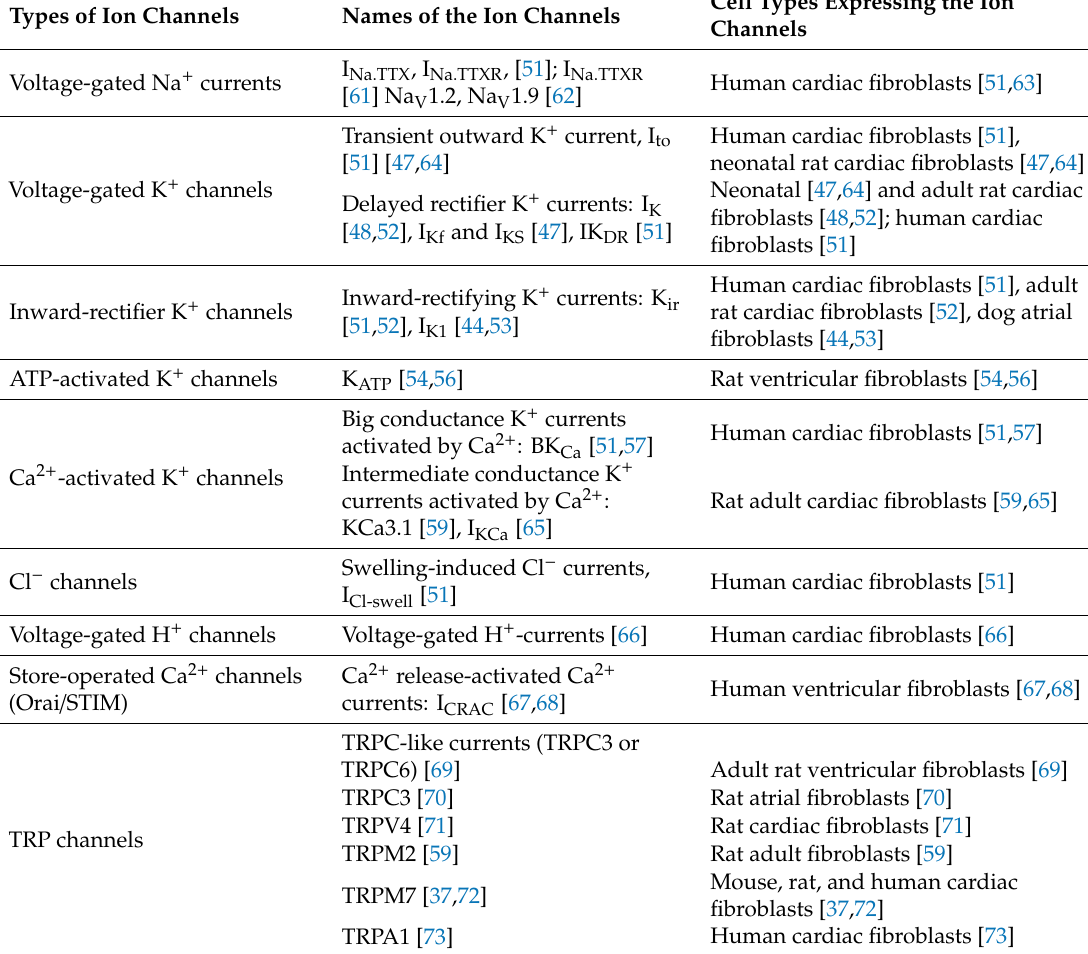
Table 1. Membrane currents in cardiac